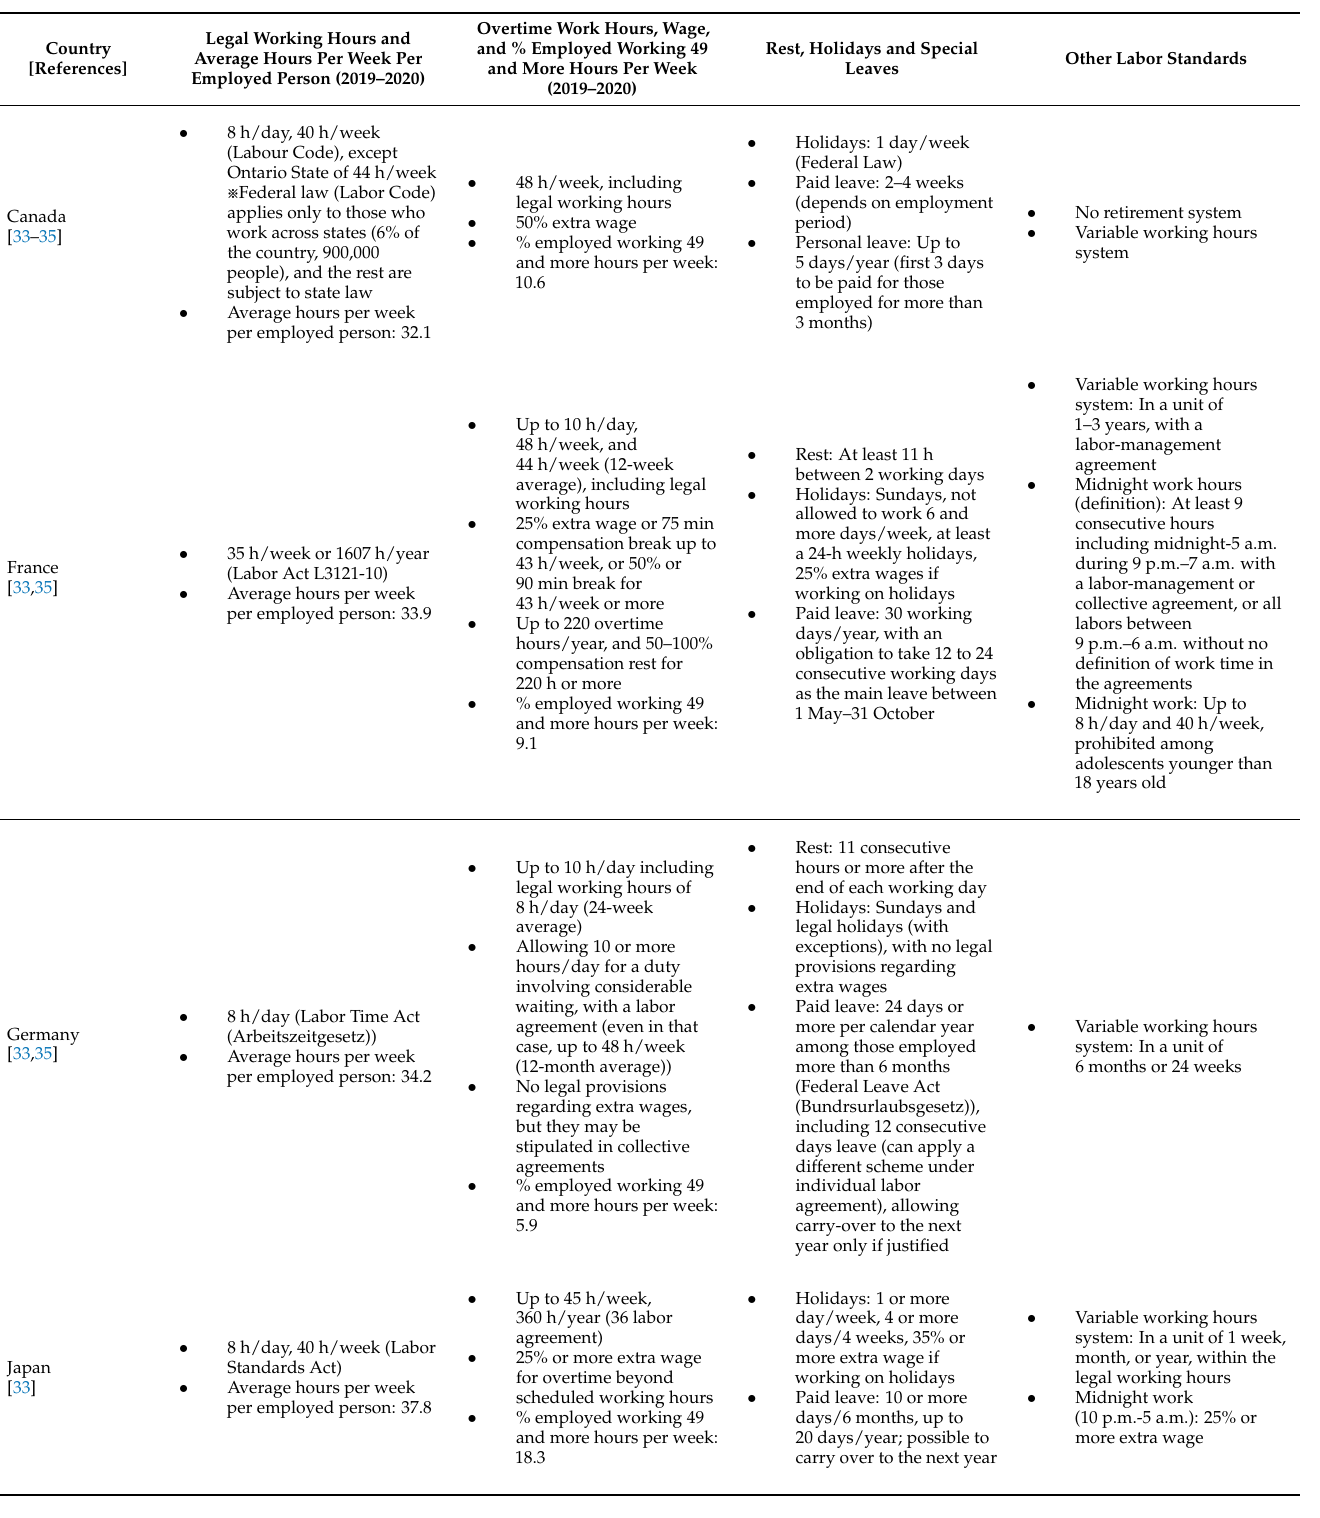
Table 2. Occupational health regulations among seven